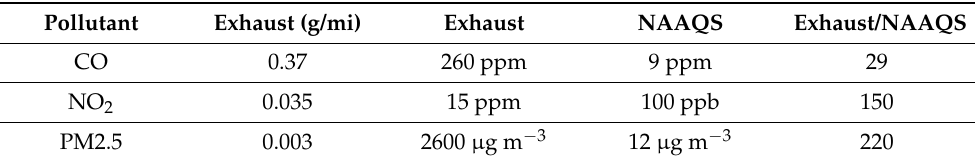
Table 2. Pollutant concentrations in raw undiluted exhaust typical of the on-road 2020 fleet compared to NAAQS (ppm and ppb units are on a volume